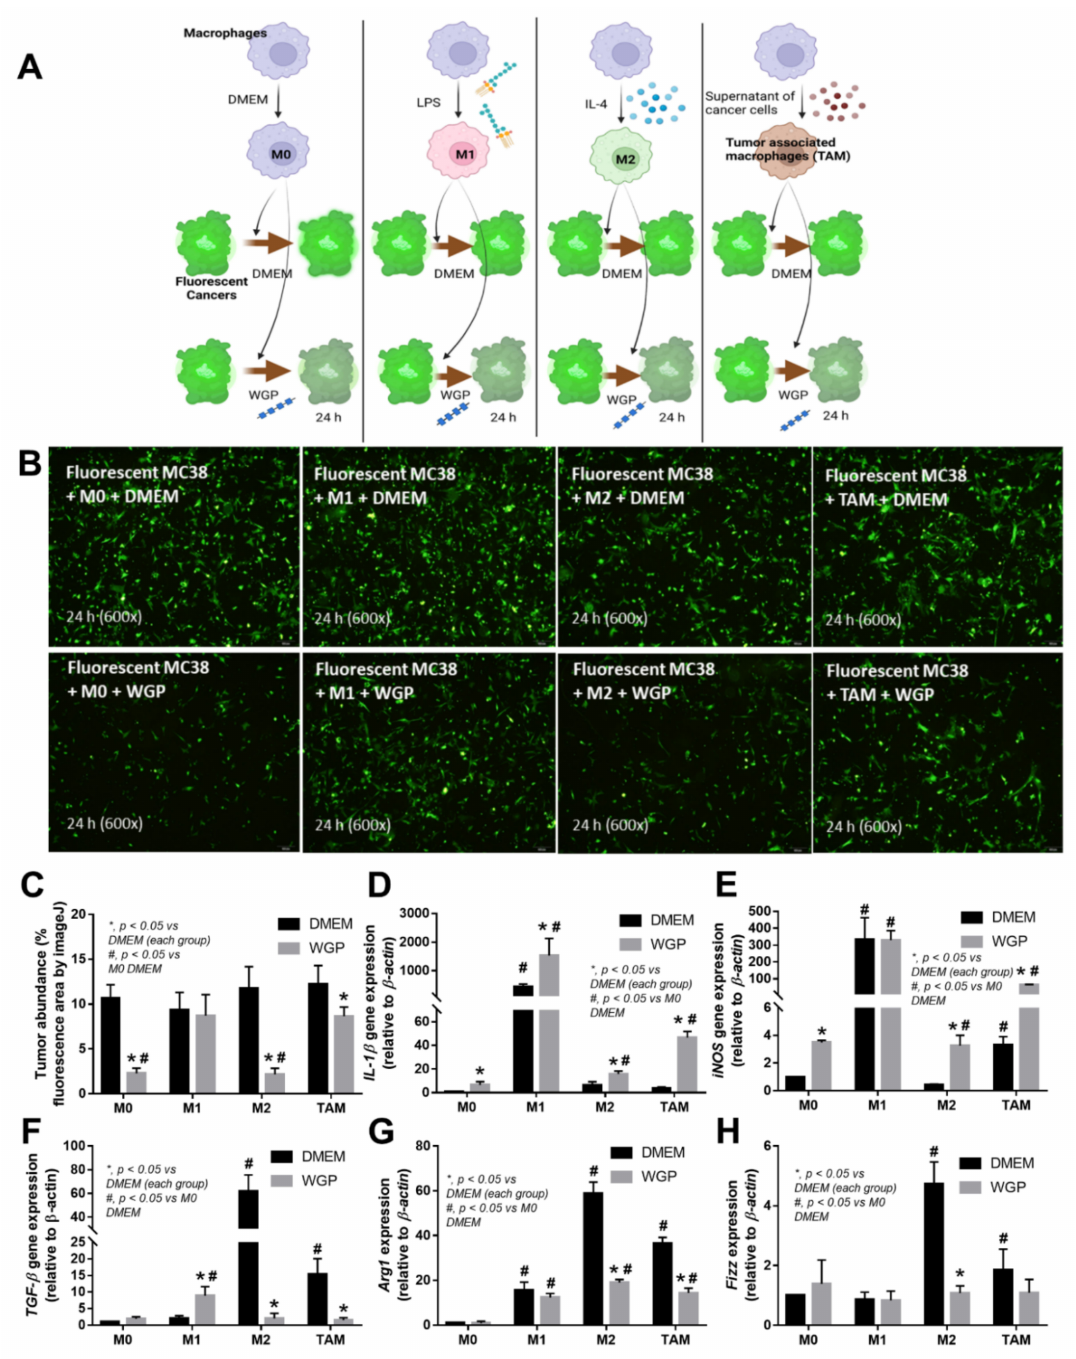
Figure 4. Schema of the in vitro experiments ( A ) with the incubation of fluorescence-stained colon cancer cell line (MC38) with different bone marrow-derived macrophages of the wild-type mice, including M0 (incubation with DMEM control media), M1 (LPS activation), M2 (IL-4 stimulation), and tumor-associated macrophages (TAM; using MC38 supernatant), together with whole glucan particle (WGP) or DMEM media control ( A ), with the characteristics of DMEM- or WGP-activated experiments, as indicated by tumor burdens (fluorescent intensity with the representative pictures) ( B , C ), genes of M1 macrophage polarization (pro-inflammation) ( IL-1 β and iNOS ) ( D , E ), and M2 polarization (anti-inflammation) ( TGF- β , Arg-1, and Fizz ) ( F – H ). Independent triplicate experiments were performed. *, p < 0.05 vs. DMEM in each group; #, p < 0.05 vs. M0 (DMEM). The picture was generated by